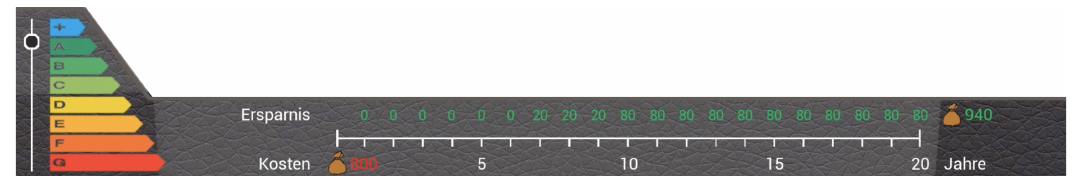
Figure 15. The energy passport gauge of the 3D-Infokit prototype.